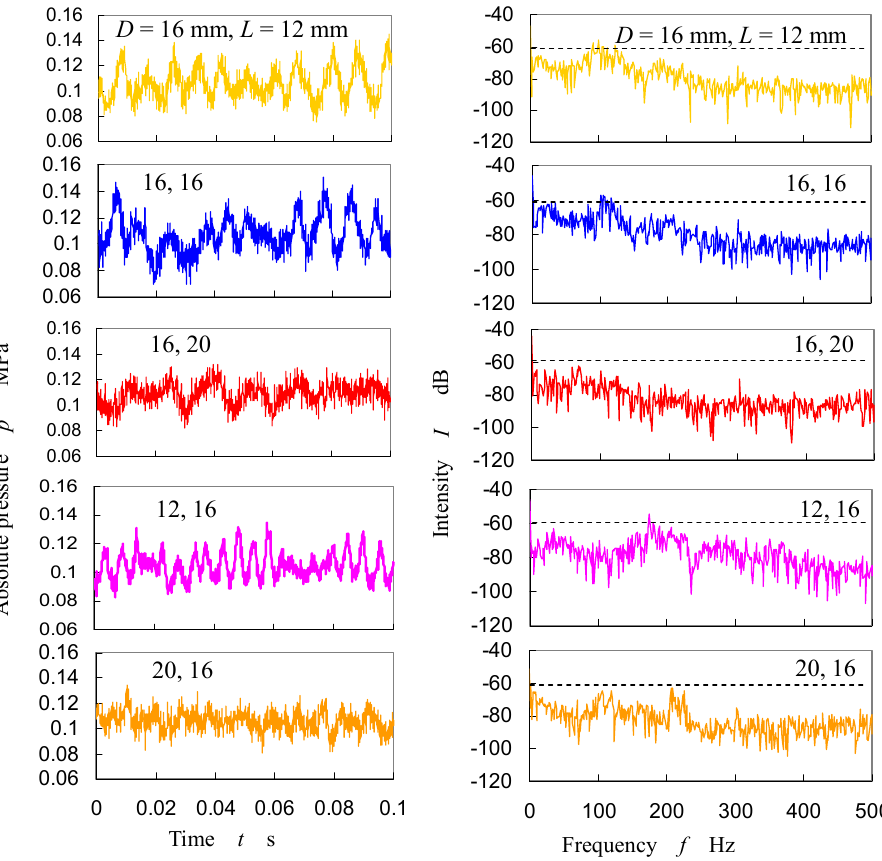
Fig. 4 Pressure fluctuation at the target for various D and L ( p = 30 MPa, p = 0.1 MPa, σ = 0.003, d = 2 mm, D 1 2